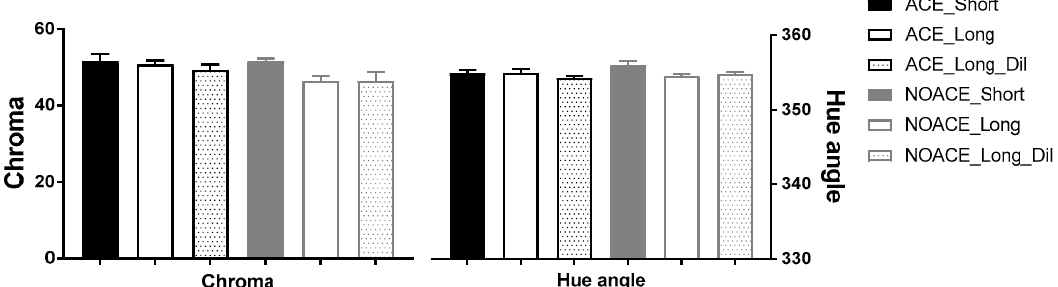
§ Superscript represents that a.u. is the absorbance units. † Data are the means (± standard deviation) of triplicate fermentations, analysed with one-way analysis of variance at an alpha level of 5% and Fisher’s least significant difference test. ‡ Bold p values represent the significant differences between the treatments. A post hoc test was run across the wines within each column; the values followed by the same letter in a column are not significantly different.